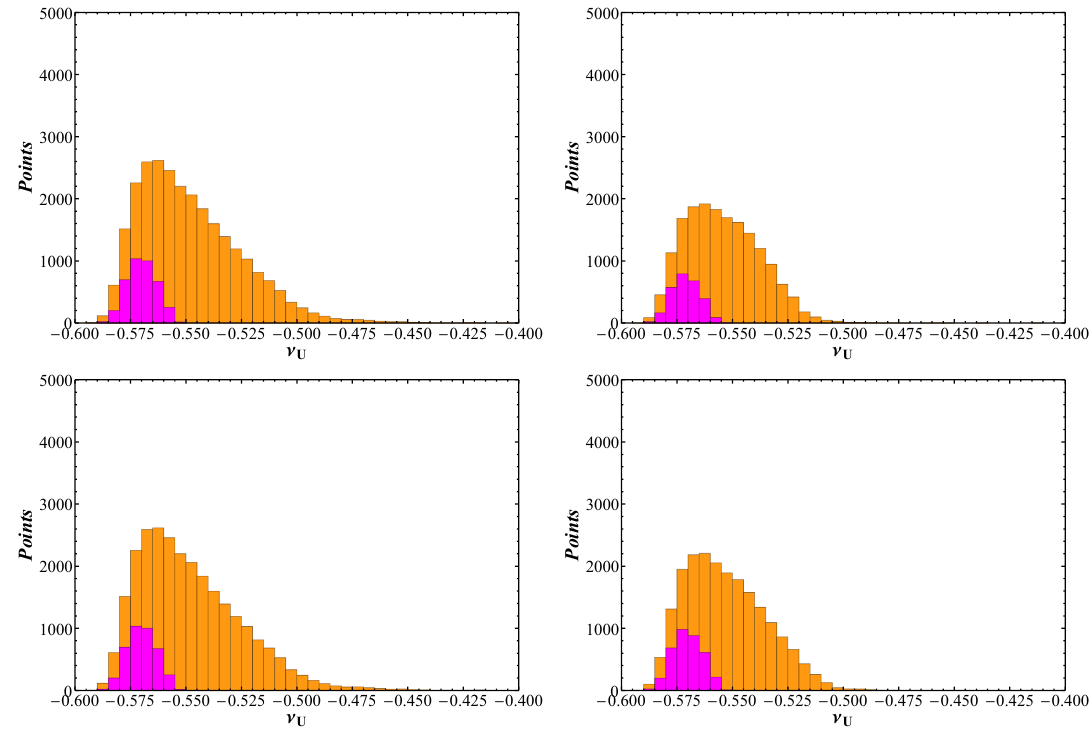
Figure 15. Histograms of the (cid:23) U for g A = g B = 0 : 1 and v F =k = 0 : 1 (top left), g A = g B = 1 : 0 and v F =k = 0 : 1 (top right), g A = g B = 0 : 1 and v F =k = 1 : 0 (bottom left), and g A = g B = 1 : 0 and v F =k = 1 : 0 (bottom right). The orange represents points which satisfy the 99.7% CL experimental limit in the h d (cid:0) (cid:27) d plane, and the magenta represents the subset of these points which also satisfy the constraint x 12 < 0 :